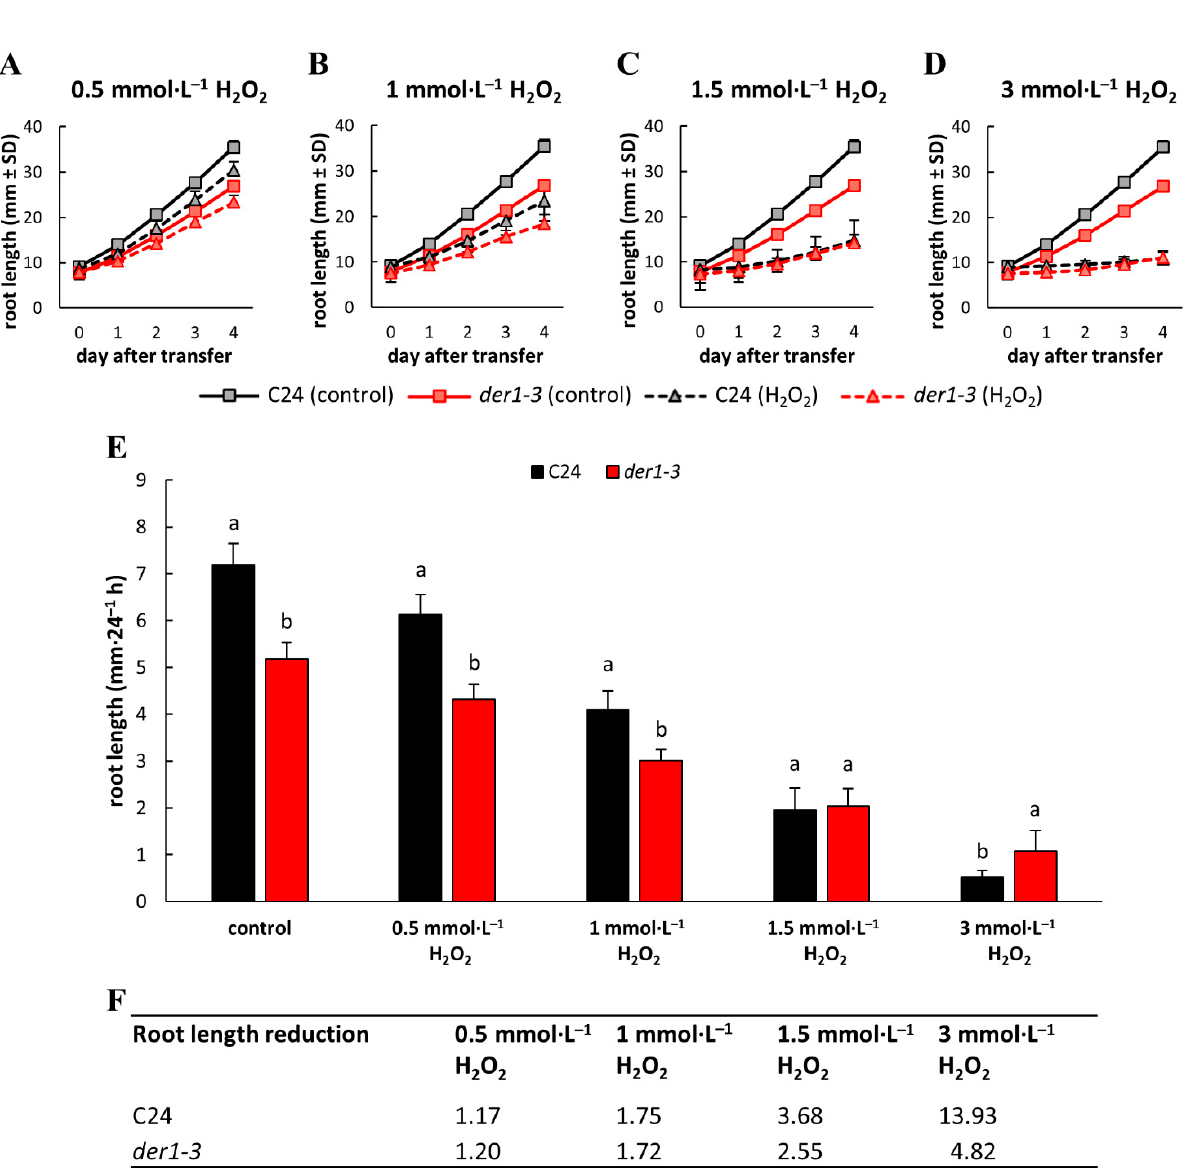
Figure 5. Root growth rate of the control C24 and der1–3 mutant plants after their transfer to H 2 O 2 -containing media. 3-day-old plants germinated on the control media were transferred to a H 2 O 2 -containing media and root growth rate was analyzed within the subsequent 4 days. ( A – D ) Root growth rate of the control C24 and der1–3 mutant plants on media containing 0.5 ( A ), 1 ( B ), 1.5 ( C ) and 3 ( D ) mmol·L − 1 of H 2 O 2 . ( E ) Average root growth per 24 h on the control media and on media containing indicated concentrations of H 2 O 2 . ( F ) Reduction ratio (fold change in respect to control) of average root growth in the control C24 and der1–3 mutant plants on media containing 0.5 ( A ), 1 ( B ), 1.5 ( C ) and 3 ( D ) mmol·L − 1 of H 2 O 2 . Experiments were repeated two times with 10 plants per line. Different lowercase letters above the bars ( E ) represent statistical significance according to one-way ANOVA and subsequent LSD test at p value < 0.05.